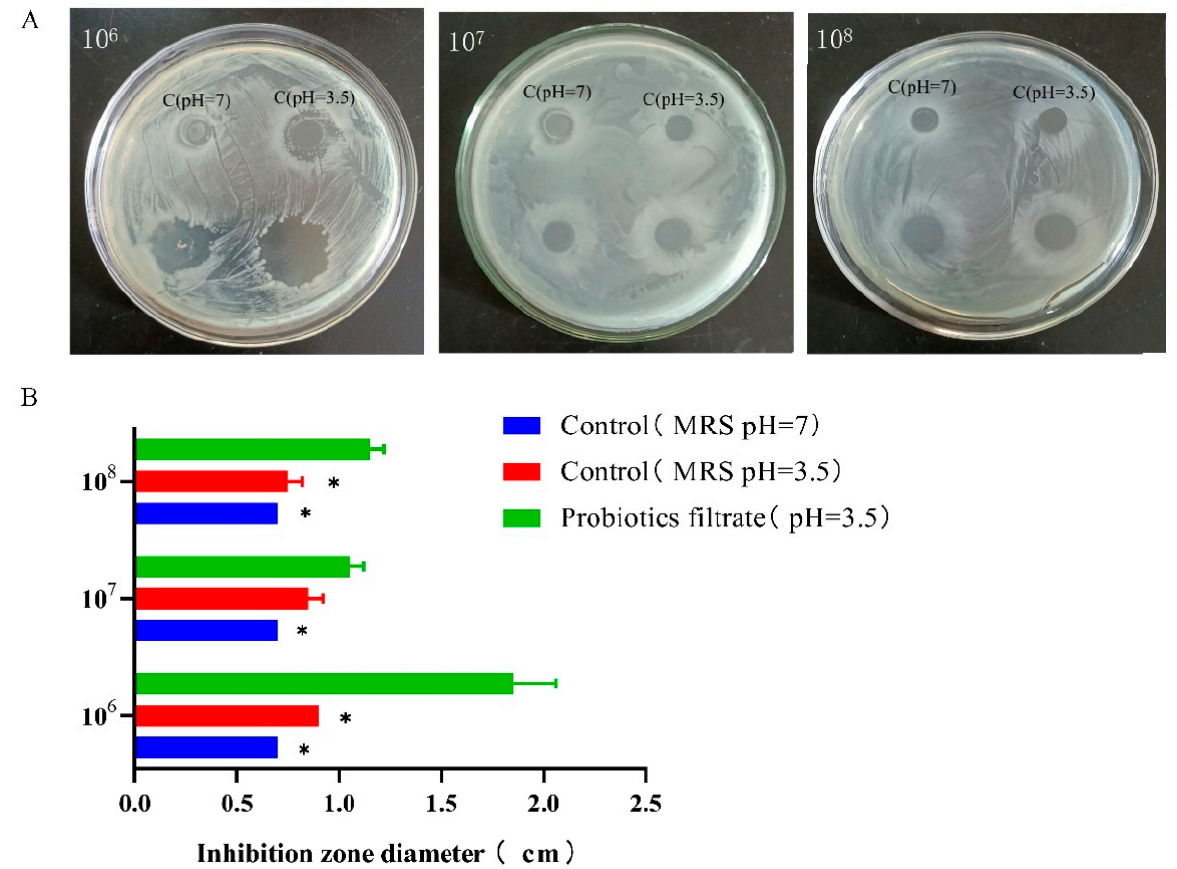
Figure 5. L. plantarum 1201 inhibits the growth of S. Typhimurium ATCC 13311. ( A ) Intuitive diagram of inhibition zone; ( B ) Bar graph of inhibition zone. * p < 0.05; paired two-tailed t